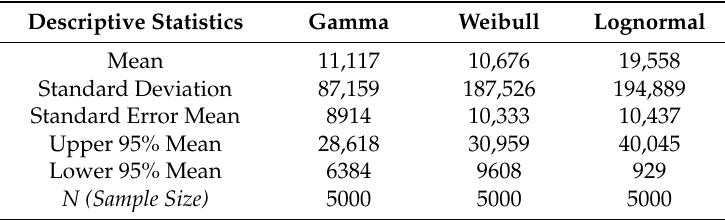
Table 11. Comparison of root mean square error (RMSE) between empirical data GLMs and simulation data